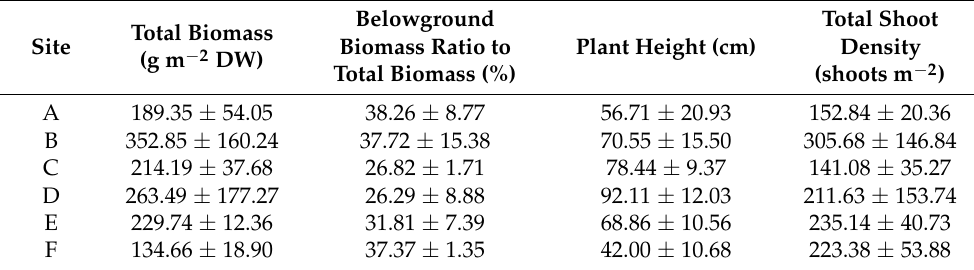
Table 2. Total biomass, belowground biomass, plant height, and shoot density values of eelgrasses at six sites in the study area on 21 August